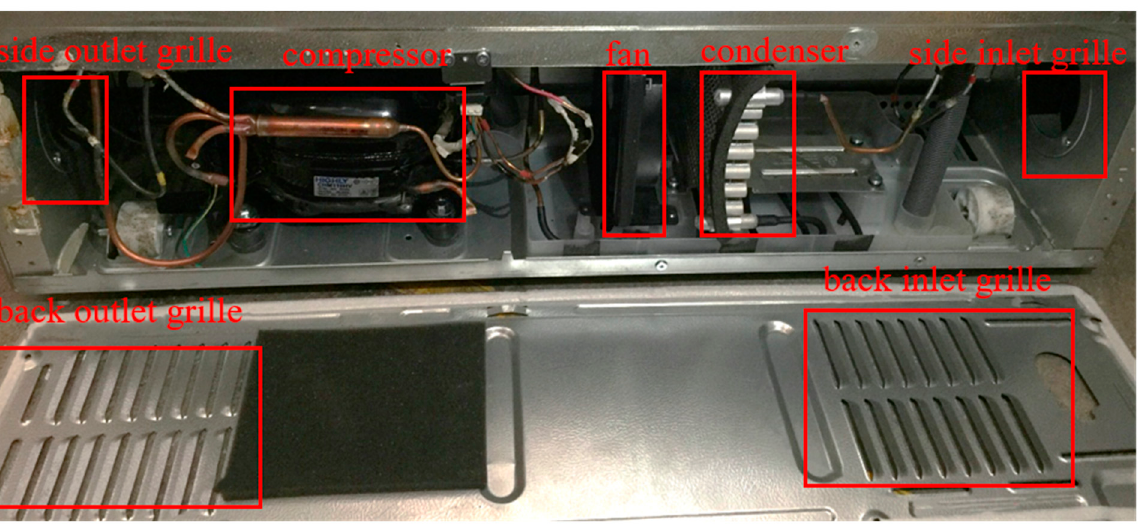
Figure 1. Structure diagram of the compressor chamber.